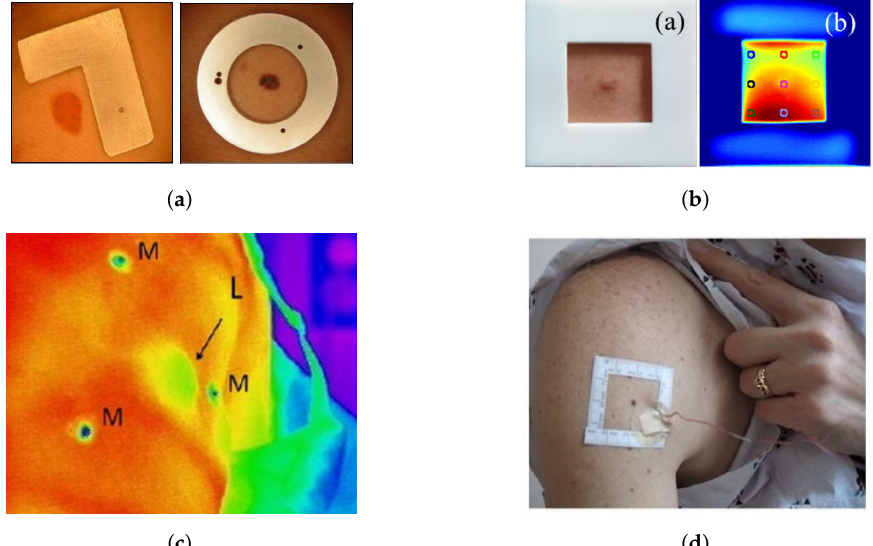
Figure 6. Region of interest markers for IR thermography on skin lesions used in literature. ( a ) Type of markers used by Buzug et al. Reprinted with permission from Ref. [27]. 2006, ACTA Press. ( b ) Square marker by Godoy et al. Adapted with permission from Ref. [9]. 2017, Optical Society of America. ( c ) Triangulated markers by Shada et al. Adapted with permission from Ref. [98]. 2013, Elsevier. ( d ) Square marker by Cetingül et al. Adapted with permission from Ref. [12]. 2011,